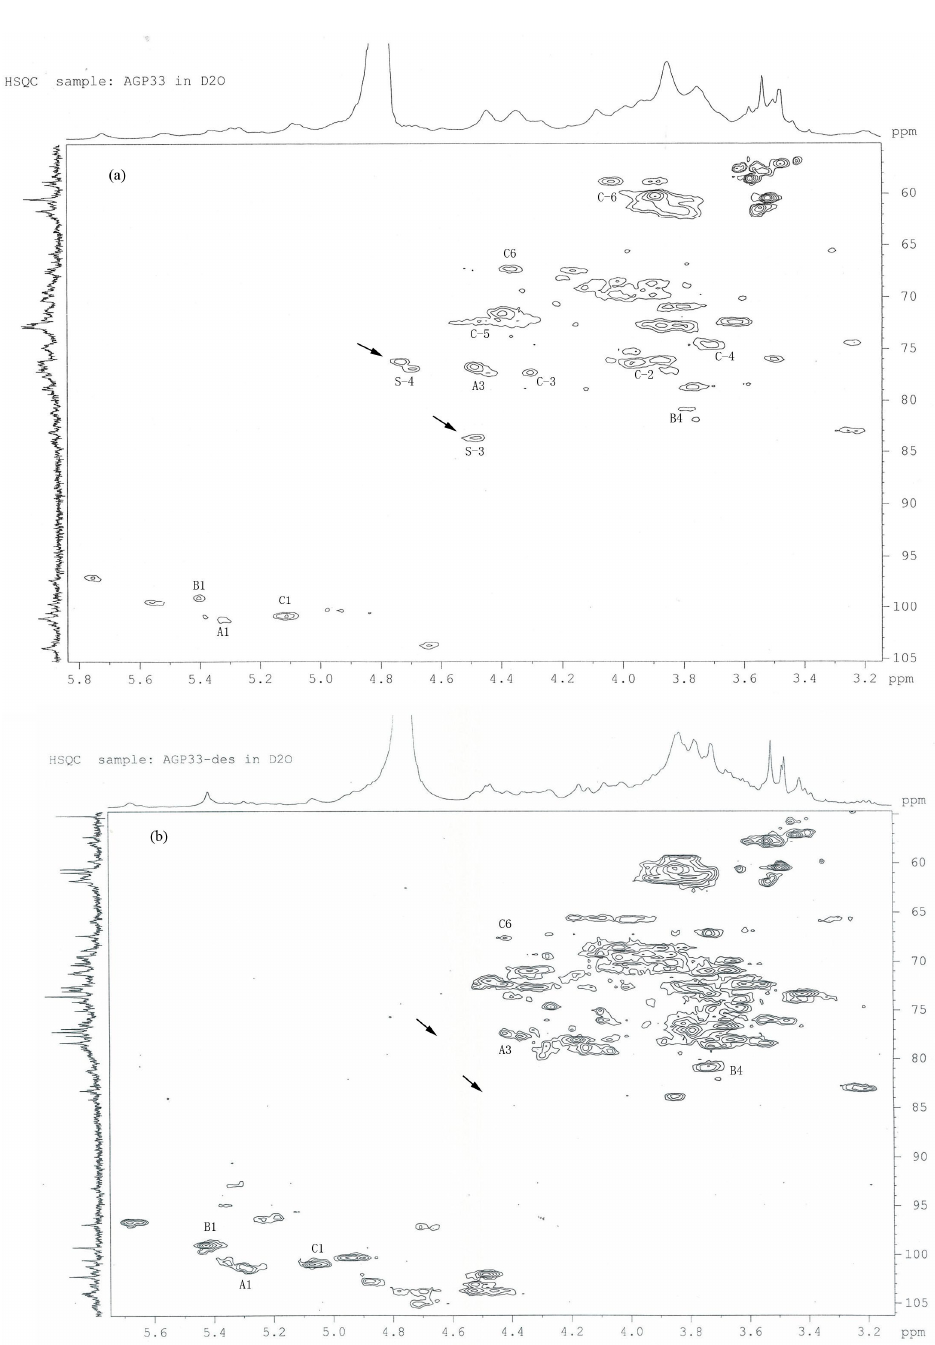
Figure 3. ( a ) HSQC spectrum of AGP33; ( b ) HSQC spectrum of AGP33-des (AGP33 without the sulfate group). The cross-peaks were assigned to 1,3- D -Glc p (residues A), 1,4- D -Gal p (residues B) and 1,6- D -Glc p (residues C). S-4: sulfate group in 4- O -position; S-3: sulfate group in 3- O -position.